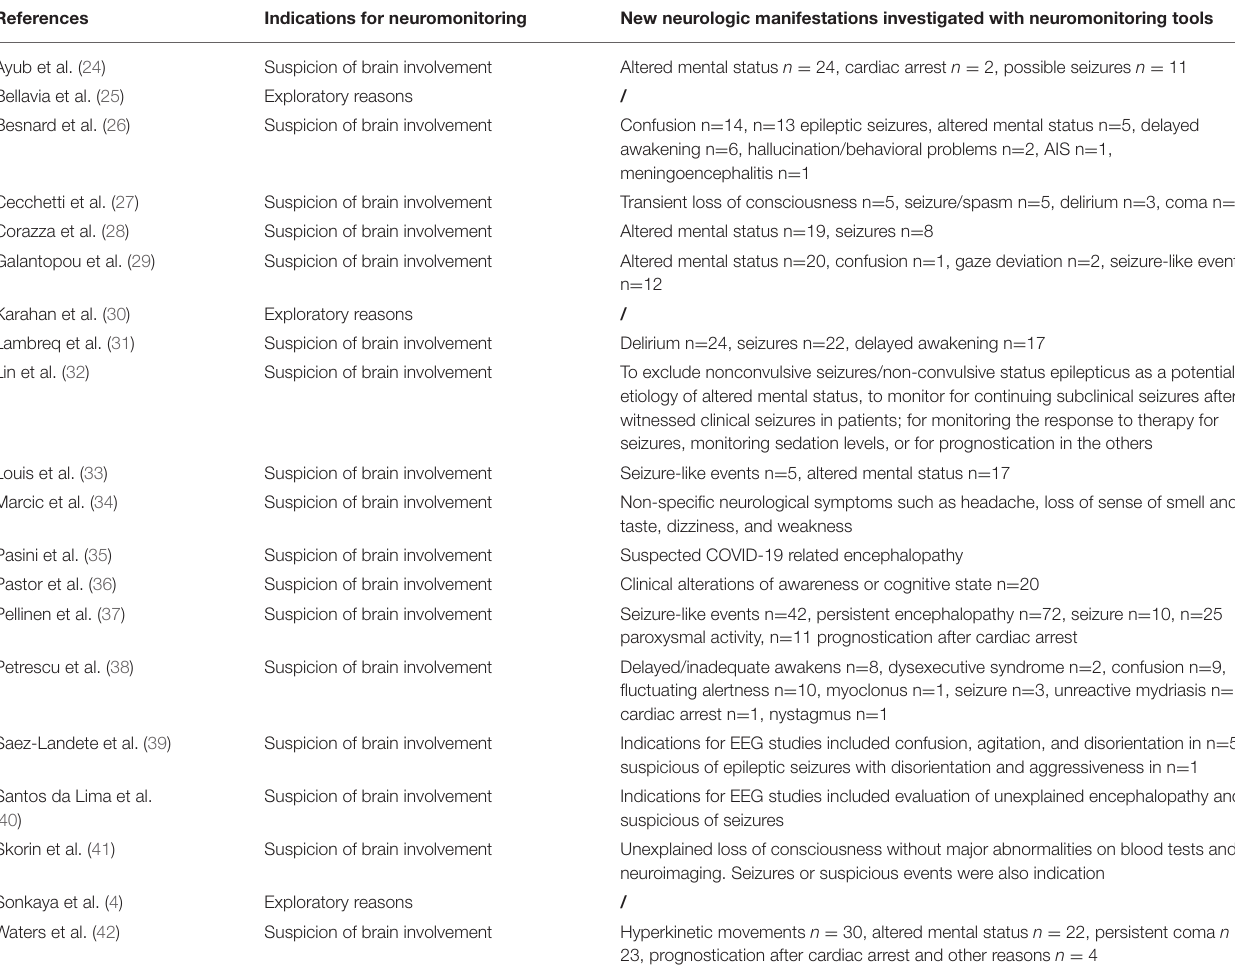
TABLE 1 | Indications for neuromonitoring and new neurological manifestations in non-critically ill patients with